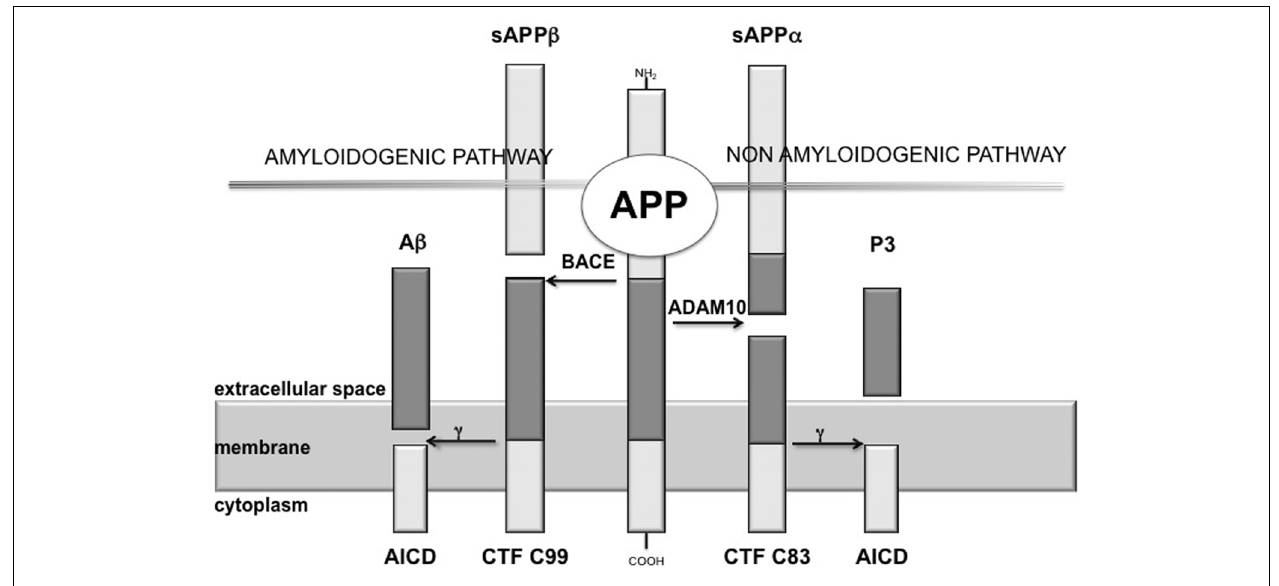
cleaves APP at the N-terminus of the A β sequence, releasing into the extracellular space sAPP β . Proteolysis of the APP C-terminal fragments by γ -secretase is the last processing step resulting in the generation of p3 and A β ,